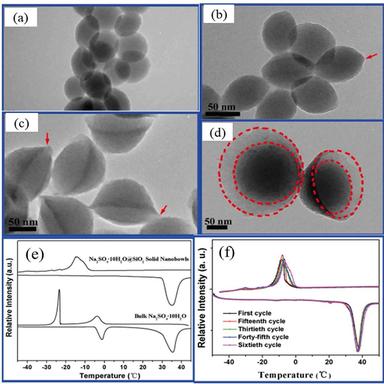
(a-d) TEM images of Na2SO4⋅10H2O@SiO2 solid nanobowls at different at different time of the reaction; (e and f) DSC curves of Na2SO4⋅10H2O@SiO2 solid nanobowls after the thermal cycles of 1, 15, 30, 45 and 60 times. Reproduced with the permission of the American Chemical Society.